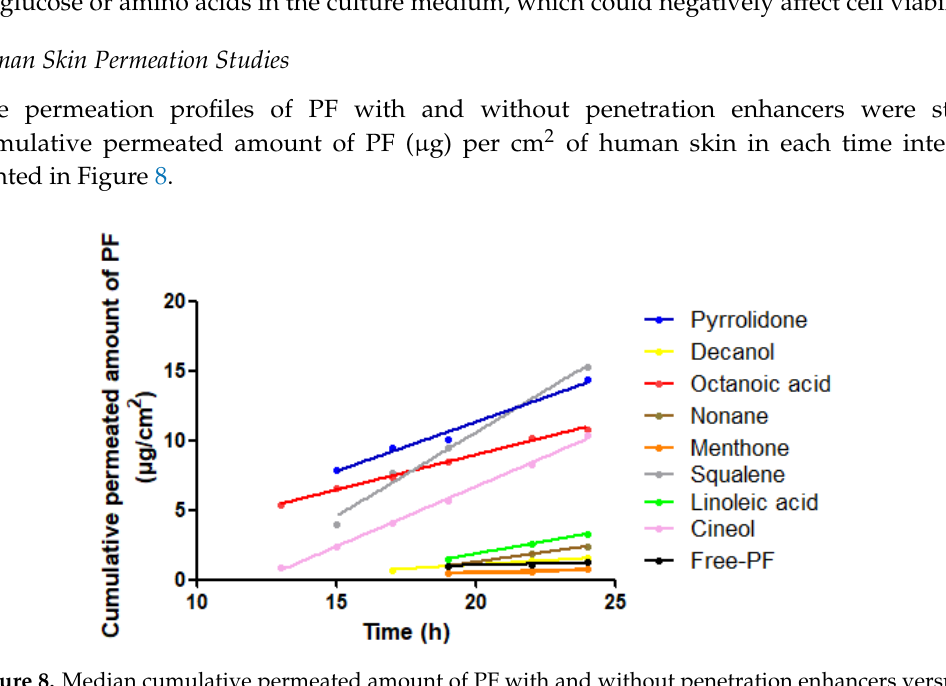
Table 4. Skin permeation parameters of PF in the presence of tested penetration enhancers. Data are represented as median (min-max).